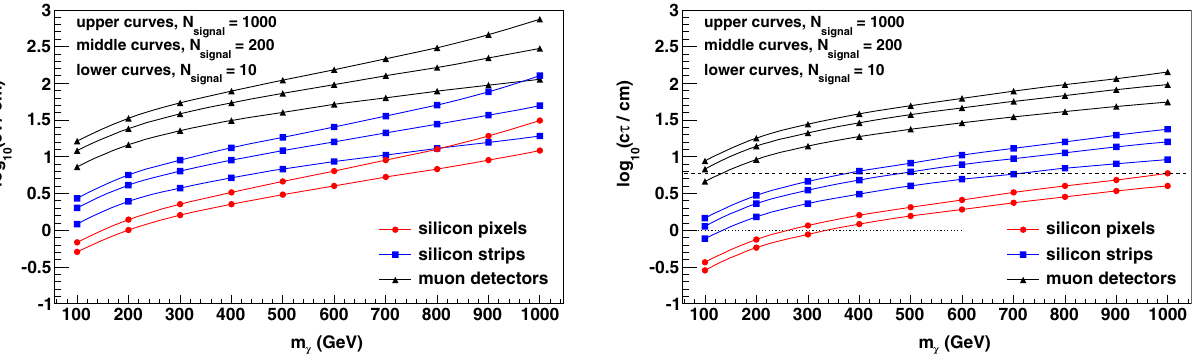
Figure 4. (Left) The discovery reach in c τ for metastable supersymmetric leptons of mass m χ for an integrated luminosity of 3 ab − 1 at the HL-LHC. The values of c τ above the curves are in the discoverable range, defined as the observation of 200 (1000) signal events for the middle (upper) curve with a given trigger system. For the muon- and silicon strip-based triggers, an additional (lower) curve corresponding to 10 signal events is also shown. (right) The corresponding discovery reach for metastable winos and higgsinos. The theoretically 6 cm for the nearly-degenerate wino’s proper decay distance 19–21 is indicated by the motivated value of c τ ∼ dashed horizontal line. It is clear that this illustrative model is rendered discoverable for wino mass values 1 cm for the nearly- beyond 1 TeV by a pixel-based track trigger. The theoretically motivated value of c τ ∼ degenerate higgsino’s proper decay distance 20,22 is indicated by the dotted horizontal line. The short-lived higgsino’s discovery in a motivated range of masses is enabled by the track trigger.